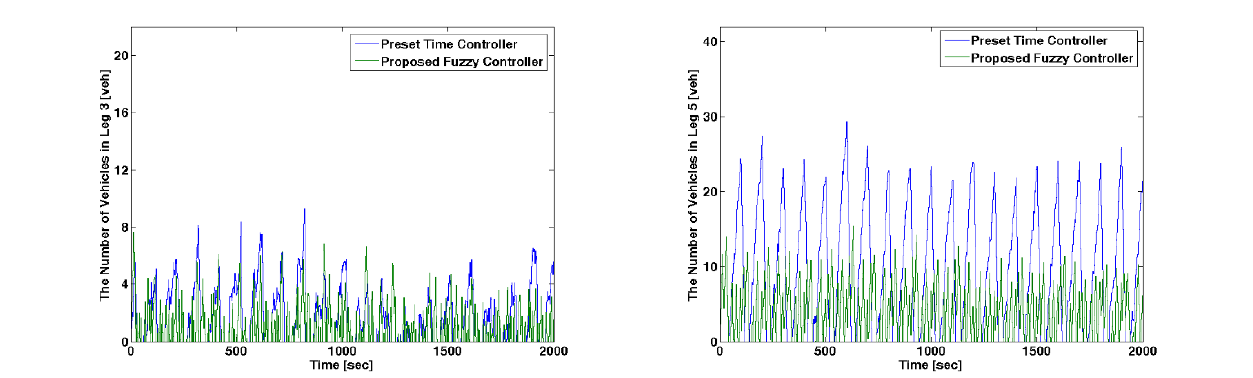
Figure 15. The number of vehicles in Leg5